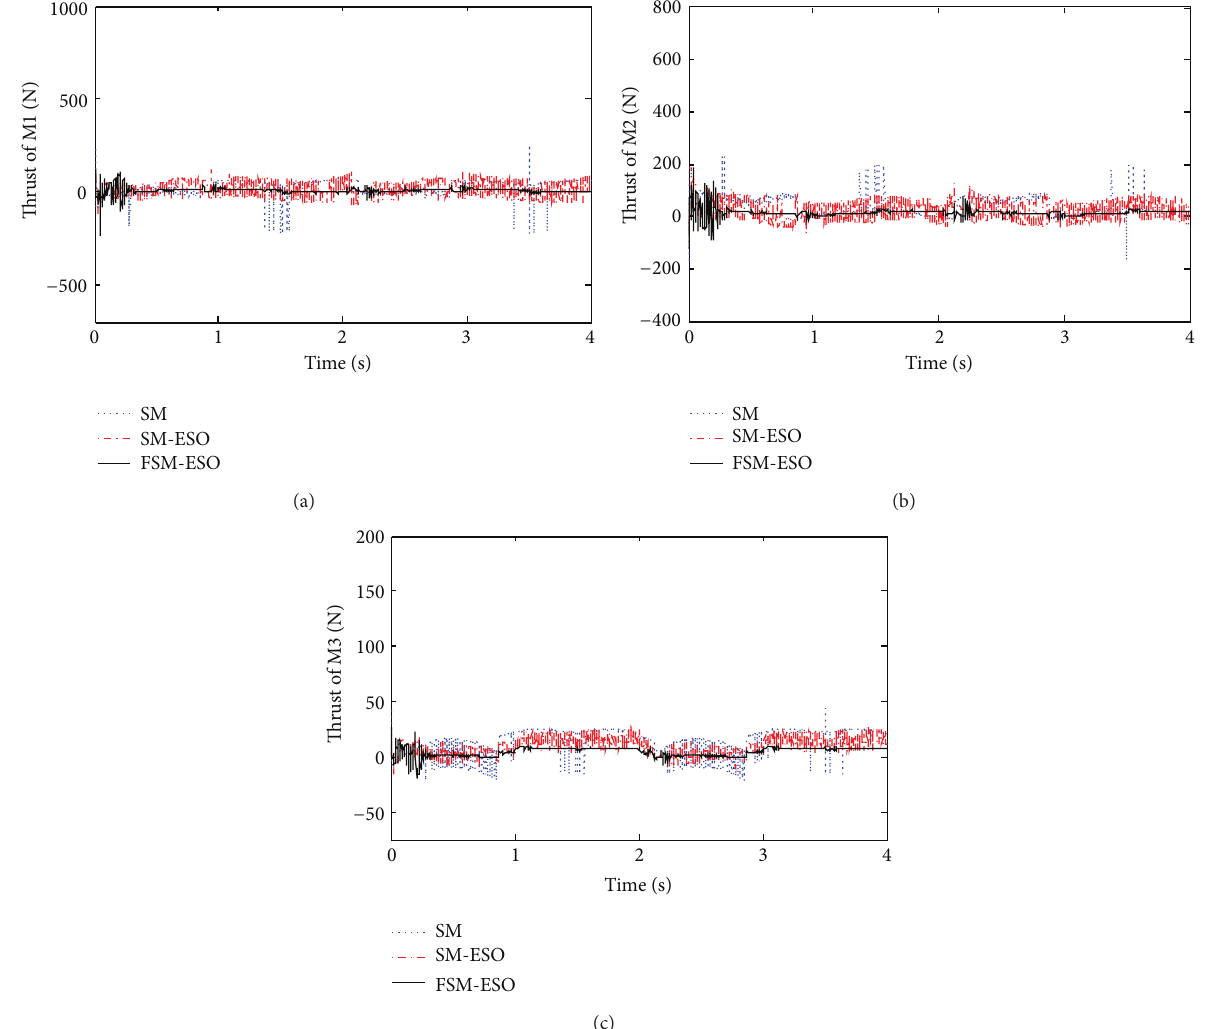
Figure 9: (a) Input thrust of M1, (b) input thrust of M2, and (c) input thrust of M3.